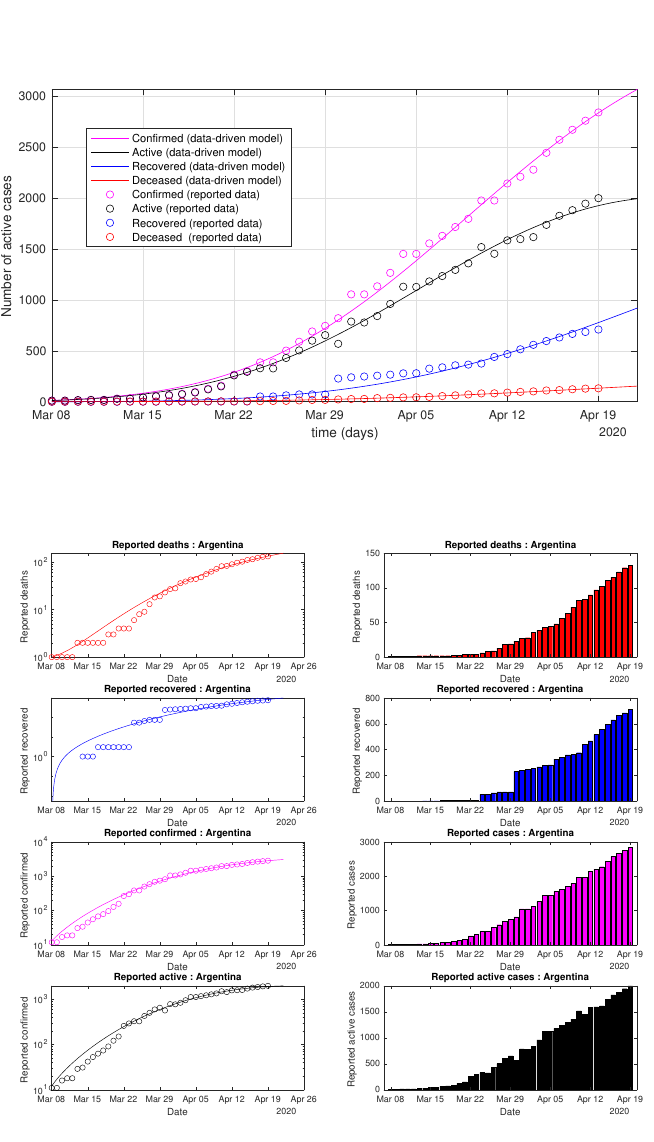
Figure 20. Argentina: data of active, recovered, deceased (in circle or bar) vs. model of active, recovered, deceased over time. Tracking the number of active cases. Predictive analytics for the next couple